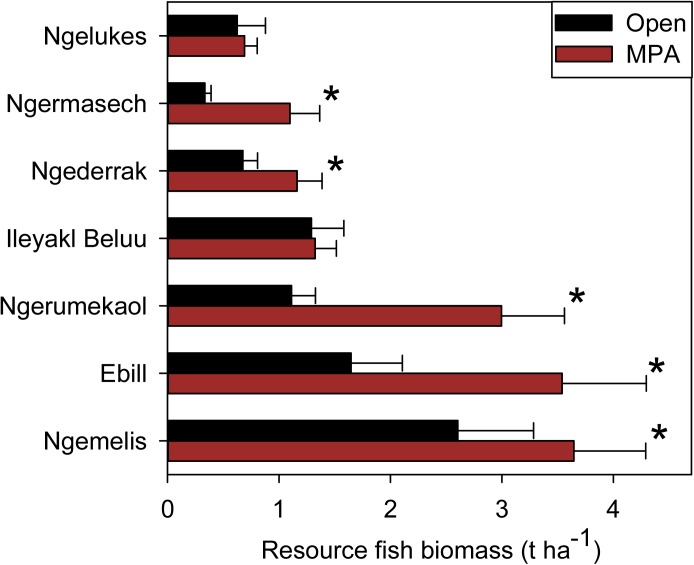
Comparison of resource fish biomass (t ha-1, mean ± standard error) inside and outside MPAs.Asterisks denote MPA/open pairs that are significantly different.